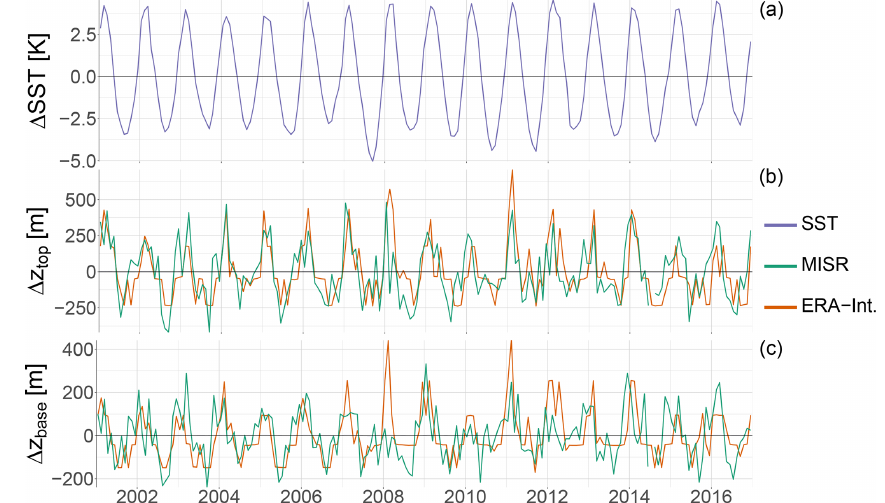
Figure 13. Time series of deviations of sea surface temperature (cid:49) SST (a) , cloud top height (cid:49)z top (b) and cloud base height (cid:49)z base (c) from the corresponding mean over the entire period from 2001 to 2016. Cloud heights are derived from MISR (green) and ERA-Interim (orange). SST is derived from